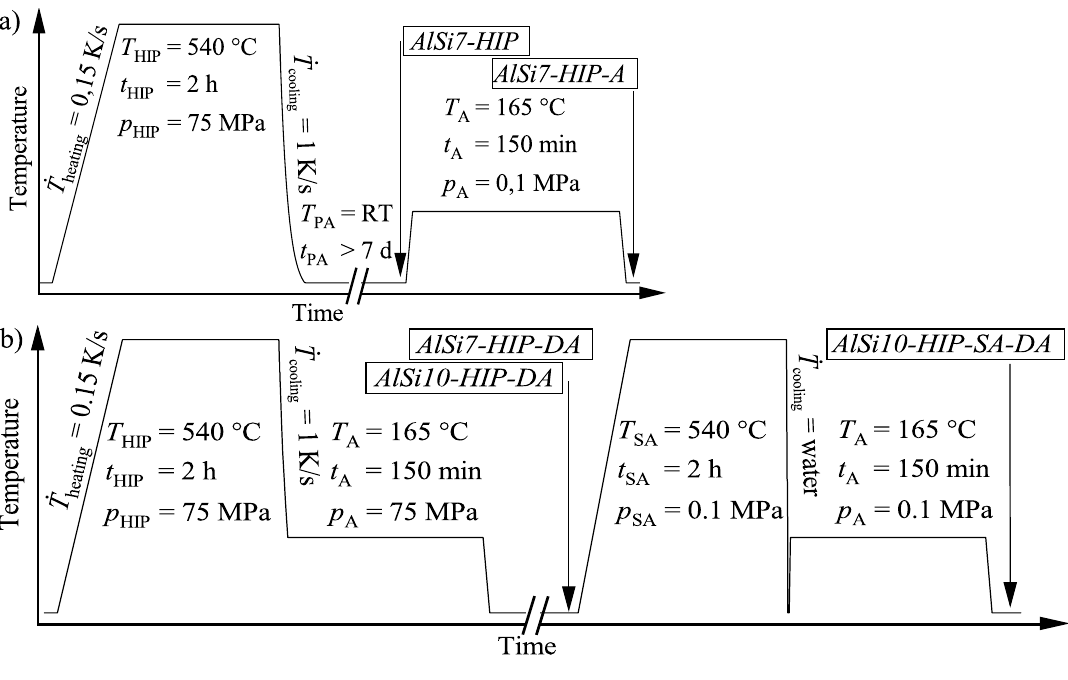
Figure 1. Temperature over time profile of all heat treatment conditions. Figure 1. ( a ) Temperature over time profile of the heat treatment conditions AlSi7-HIP and AlSi7-HIP-A ; ( b ) Temperature over time profile of the heat treatment conditions AlSi7-HIP-DA , AlSi10-HIP-DA and AlSi10-HIP-SA-DA